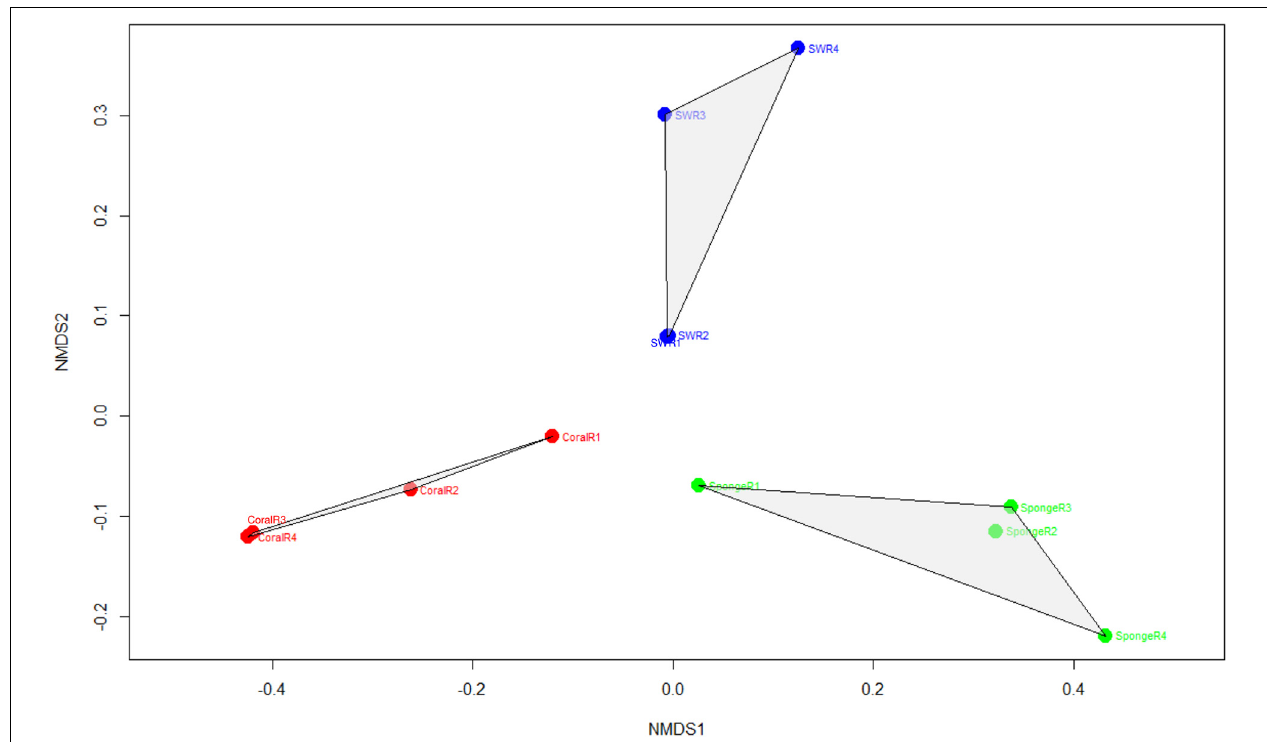
FIGURE 3 | Non-metric multidimensional scaling plots showing the pattern of Symbiodiniaceae communities recovered from the coral samples, sponge samples, and seawater (stress value: 0.12). Stress value < 0.05 shows an excellent representation in nMDS analysis.